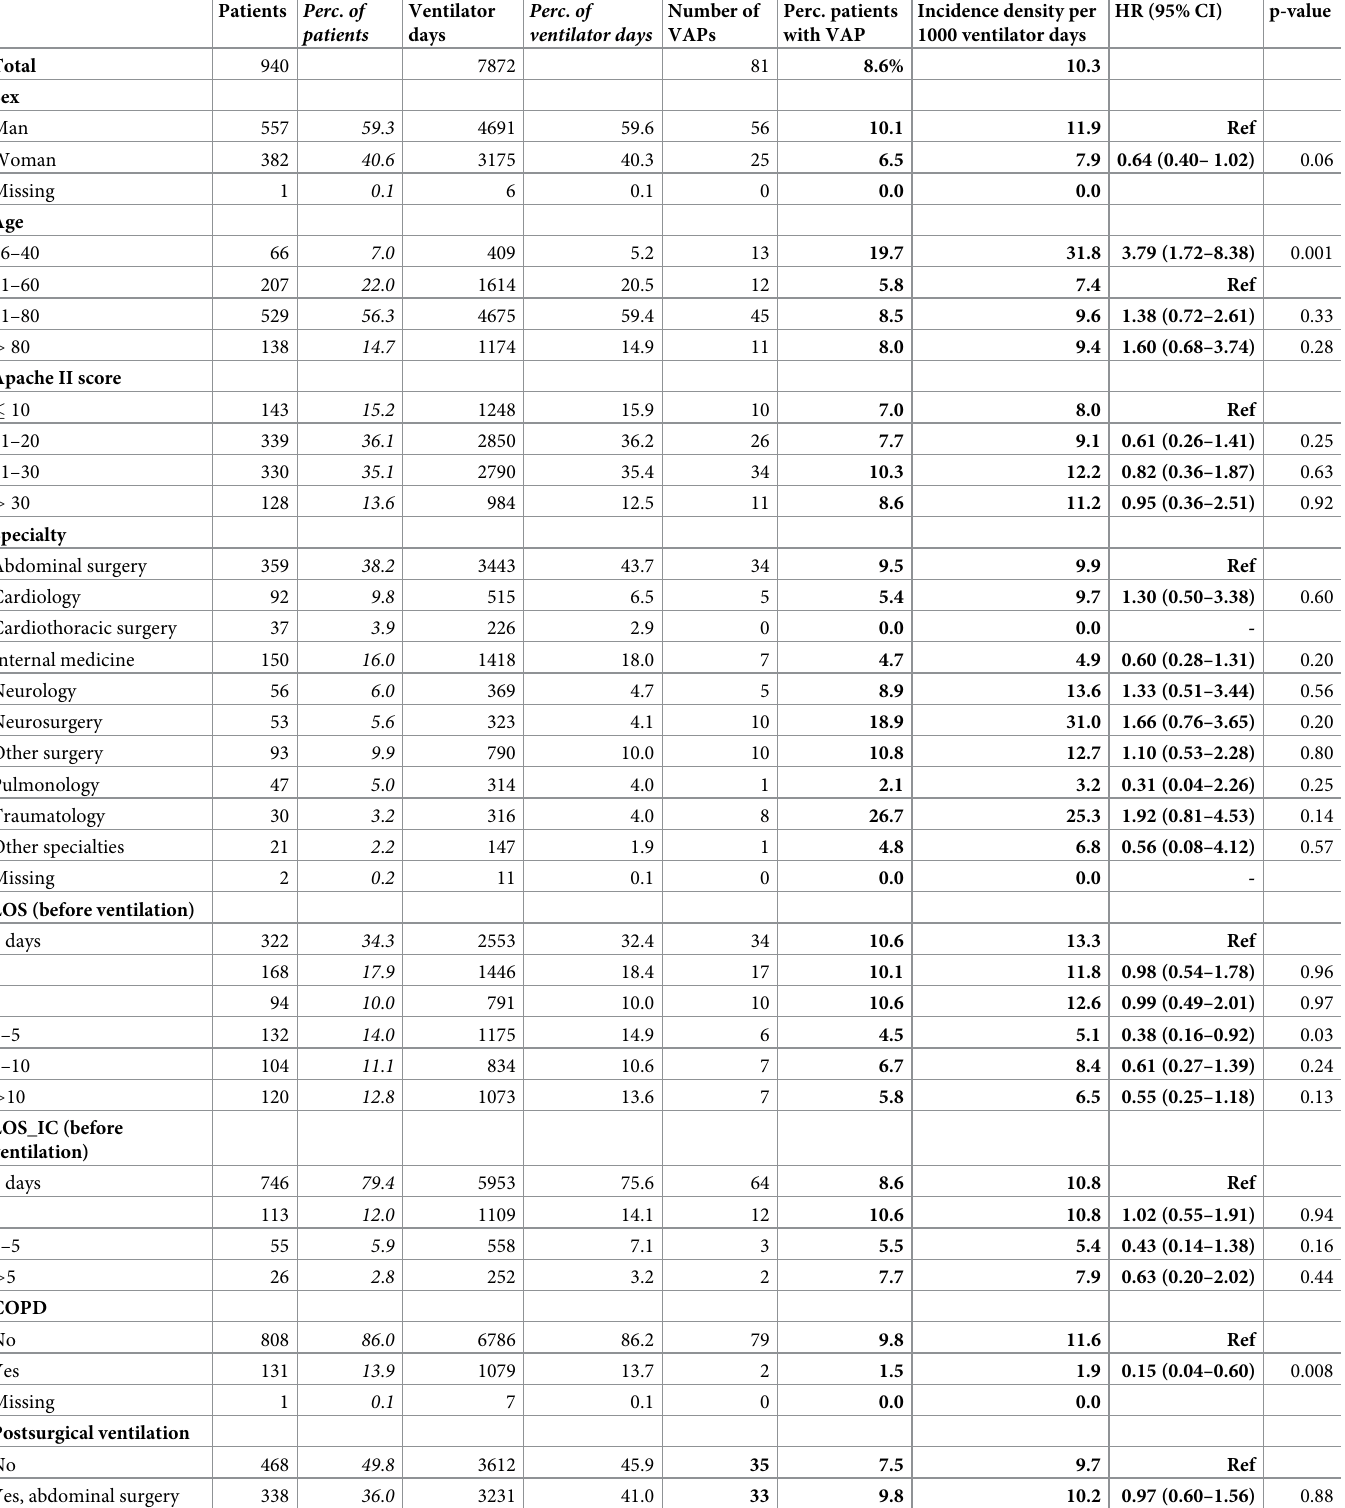
Table 1. Patient and ventilation characteristics and hazard ratios, including 95% confidence intervals and adjusted for hospital, of time-independent covariates. Patients Perc . of